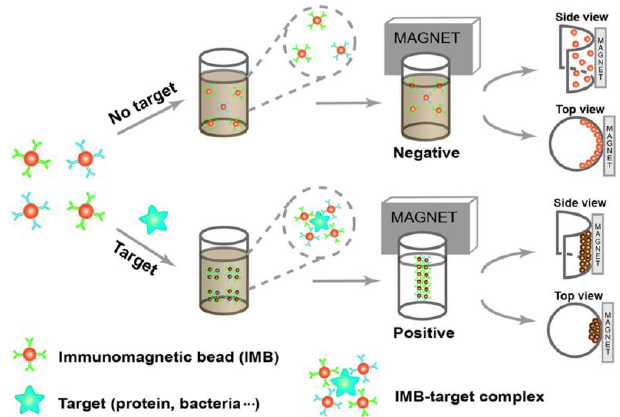
Figure 15. Sketch of the immunomagnetic aggregation technique to semi-quantitatively determine target molecule concentrations by analyzing aggregates of immunomagnetic beads formed by magnetic attraction at the wall of sample tubes. Adapted from [254] with permission of The Royal Society of Chemistry, Copyright 2015.